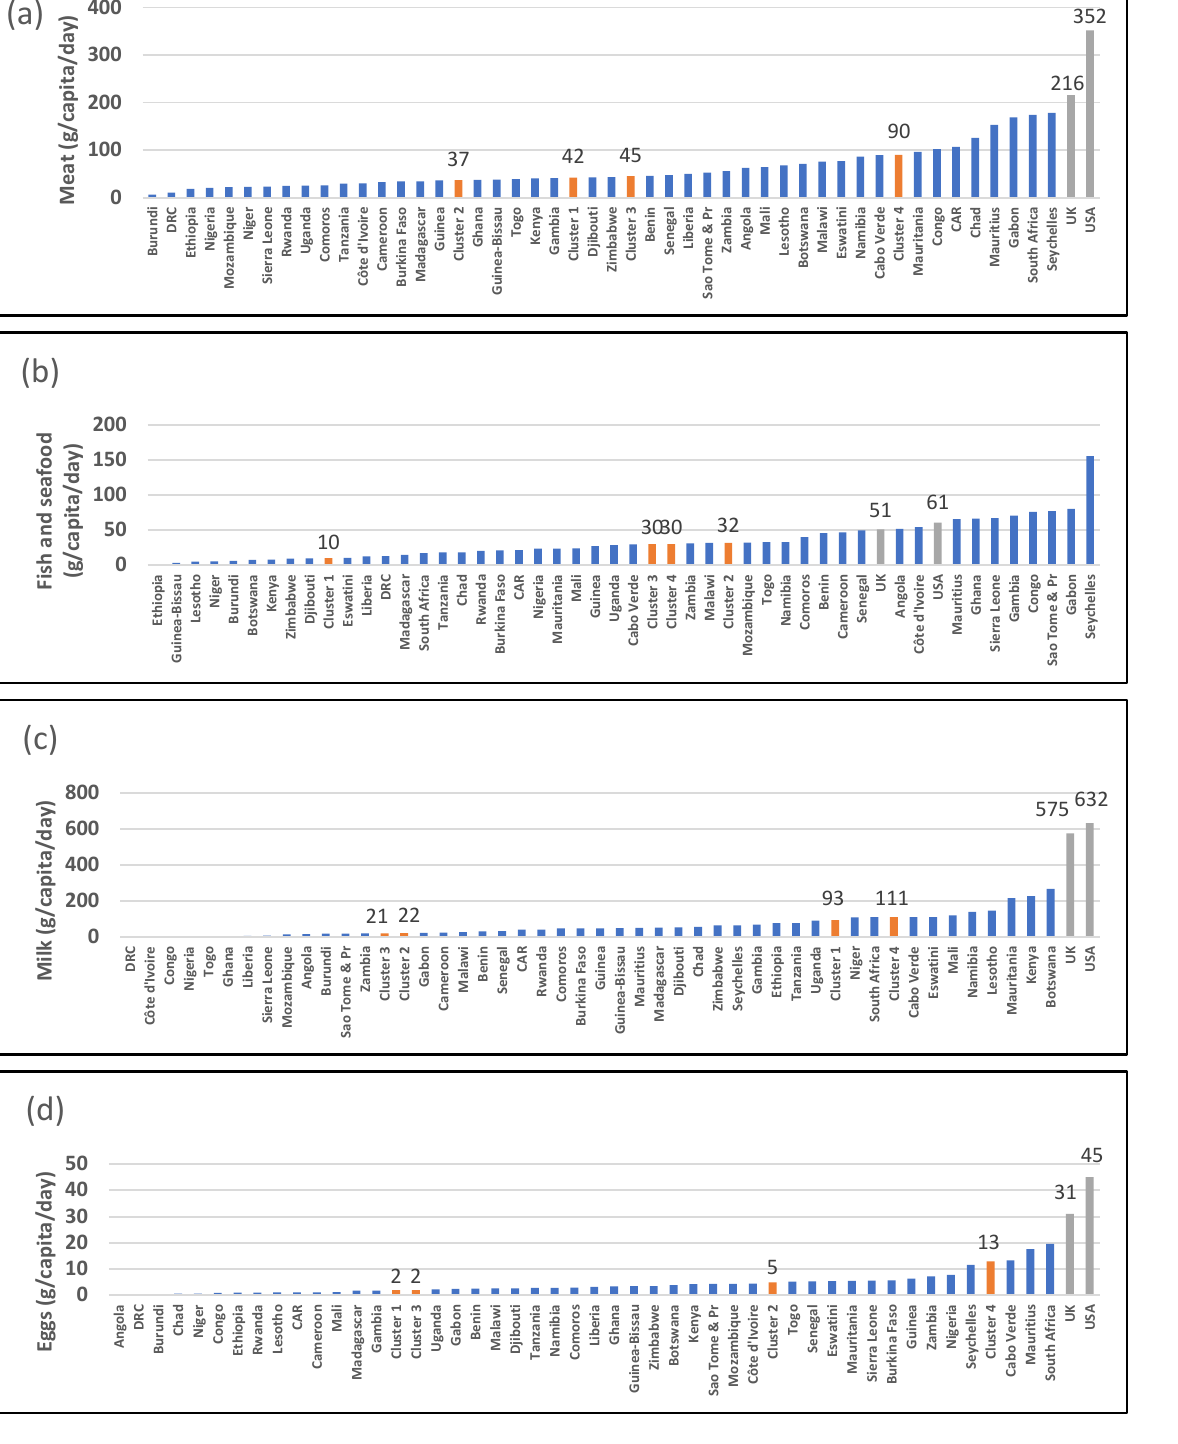
Figure 3. Data from food balance sheets for 2019 indicating gram per capita eaten per day for animal products. ( a ) meat, ( b ) fish/seafood, ( c ) milk, and ( d ) eggs. Red columns indicate medians of clusters; source: [25].